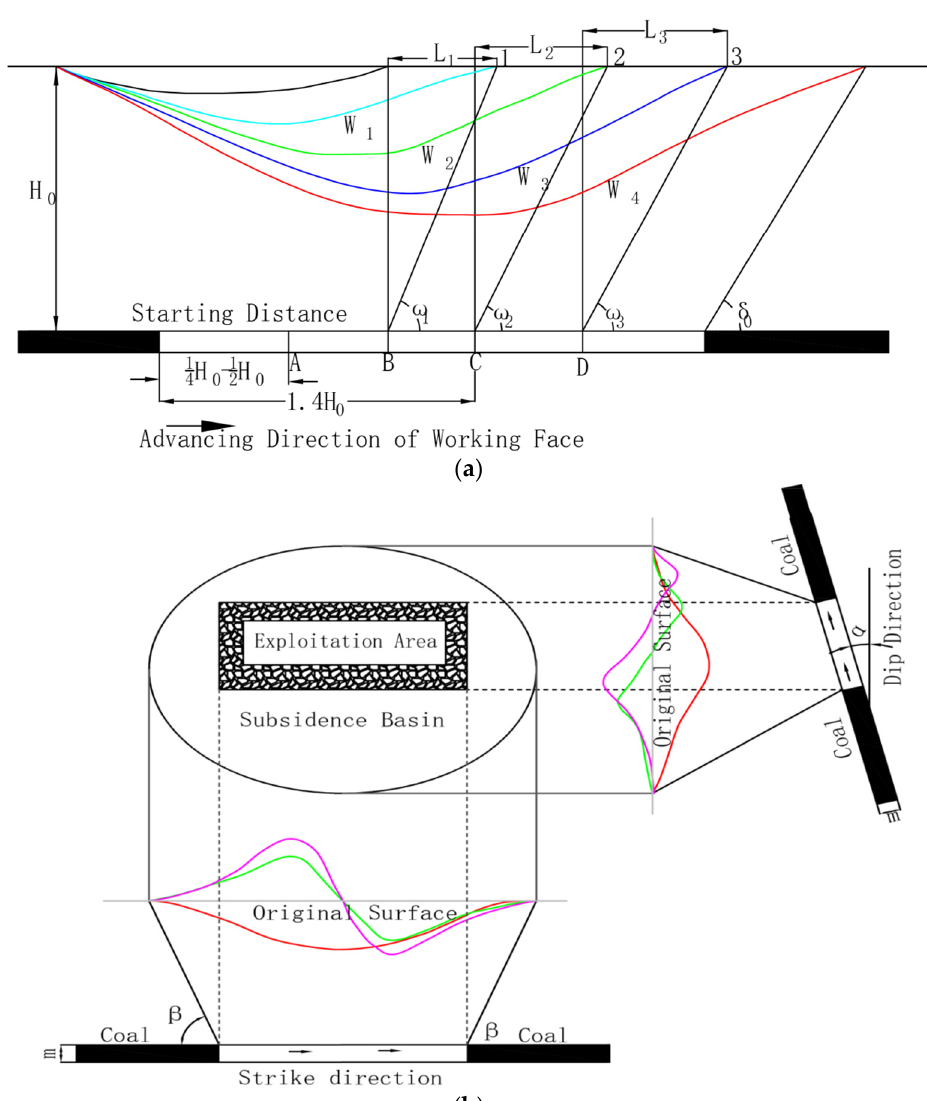
Figure 2. ( a ) Leading impact during the advancing process of the working face; ( b ) Relationship between surface movement basin and main section.